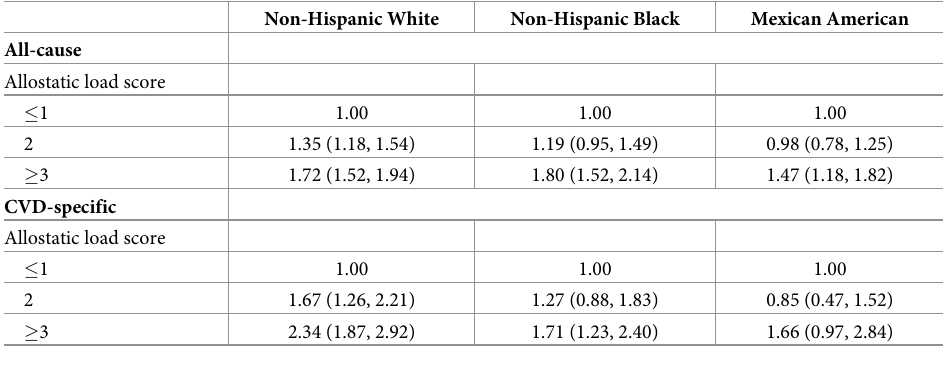
Table 5. Adjusted hazard ratios a of CVD-specific mortality risk for allostatic load score categories according to racial/ethnic groups: NHANES III-Linked Mortality File,